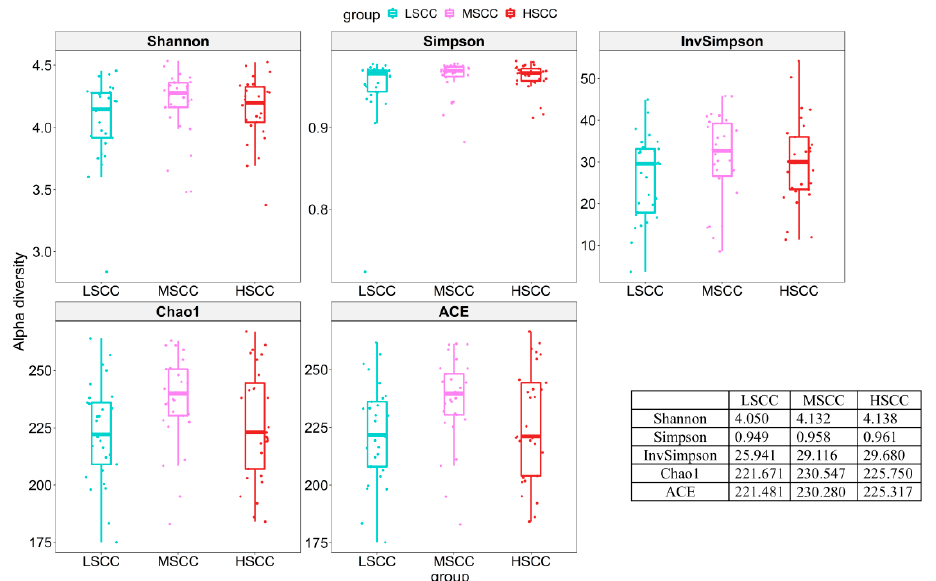
Figure 2. Boxplot showing different α diversity indices in each group. Estimated marginal means of each diversity index was assessed using mixed linear model.